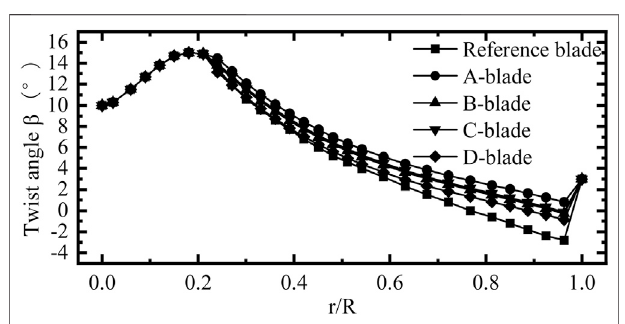
FIGURE 10 | The optimized blade twist angle distribution curves.